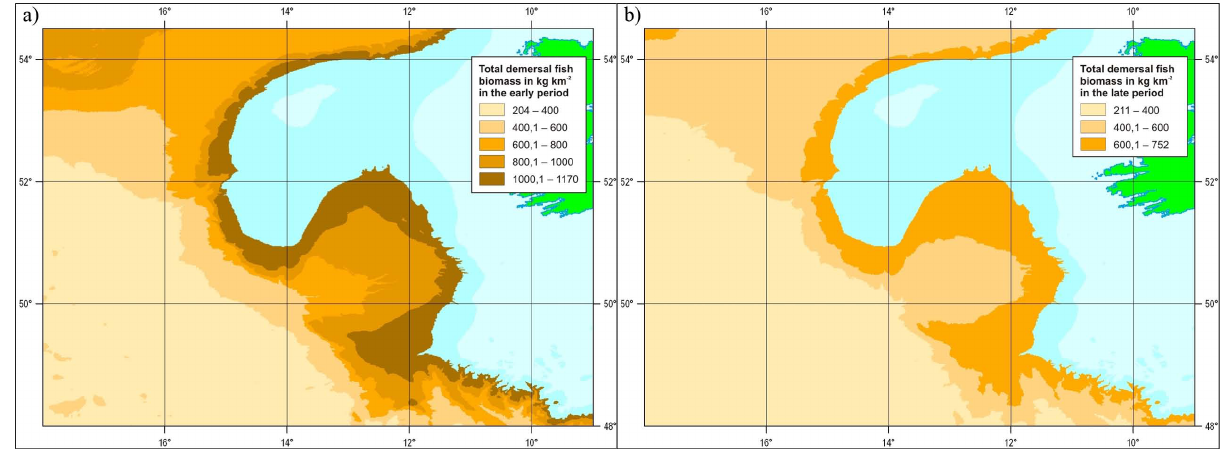
Fig. 3. The GIS predicted model of spatial distribution of total fish biomass (kgkm − 2 ) in ICES Sub-area VII (Divisions b, c, j, k) based on the regression lines in Fig. 2 for (a) the early (1977–1989) and (b) the late (2000–2002) period.